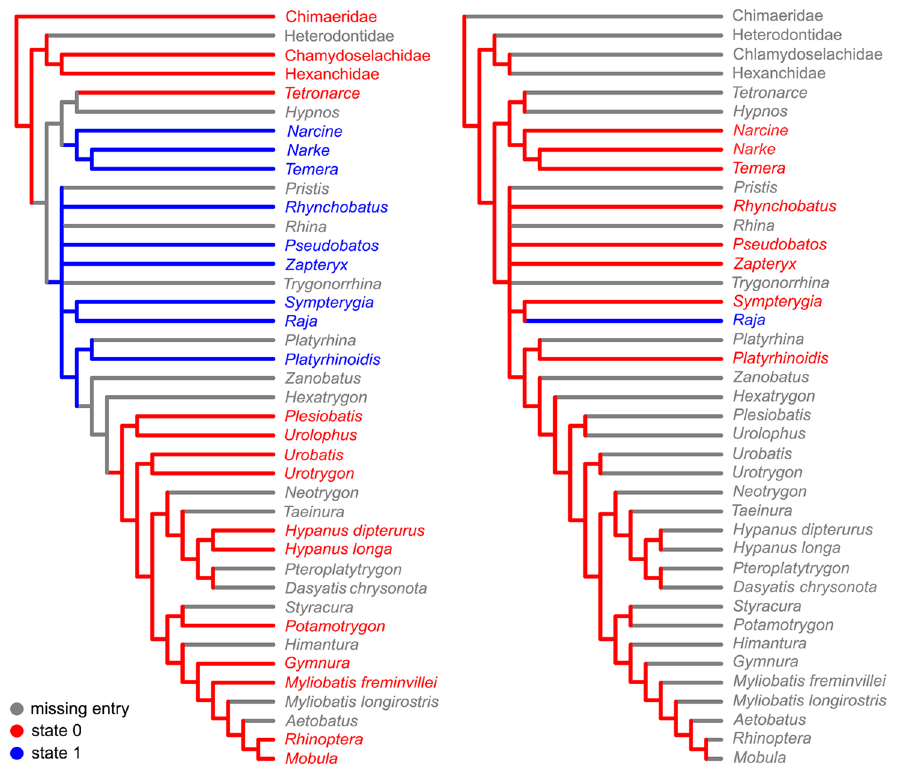
afferent branchial arteries with Aschliman’s et al. 3